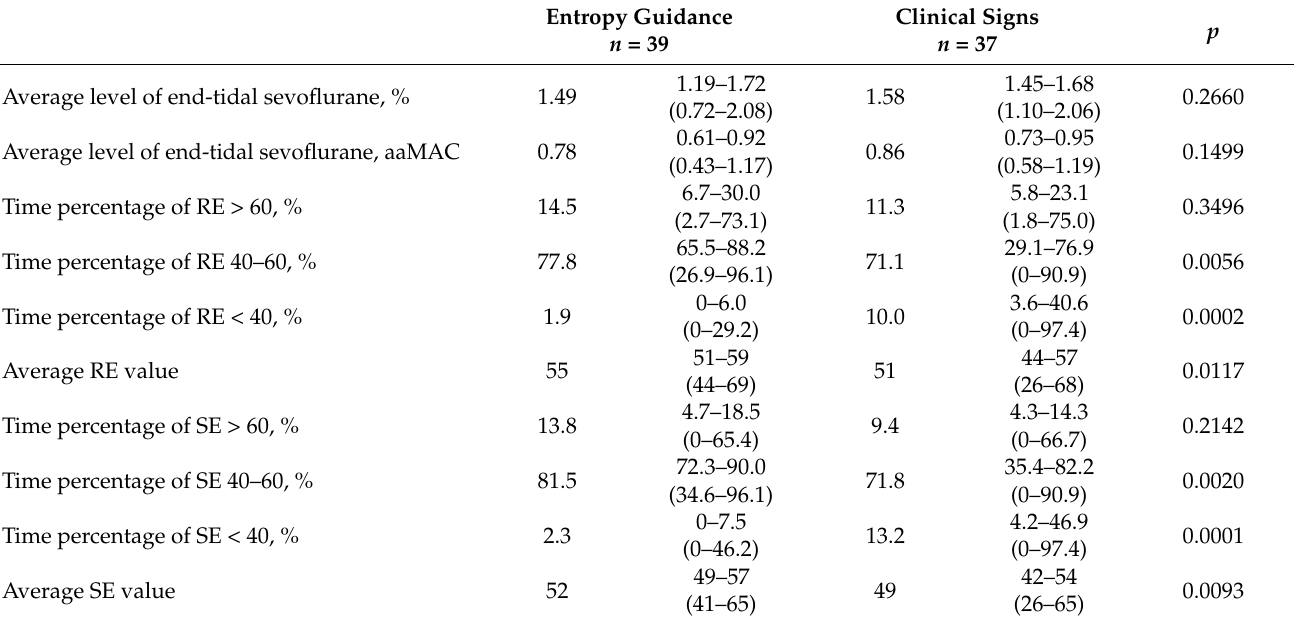
Table 3. End-tidal sevoflurane levels and entropy